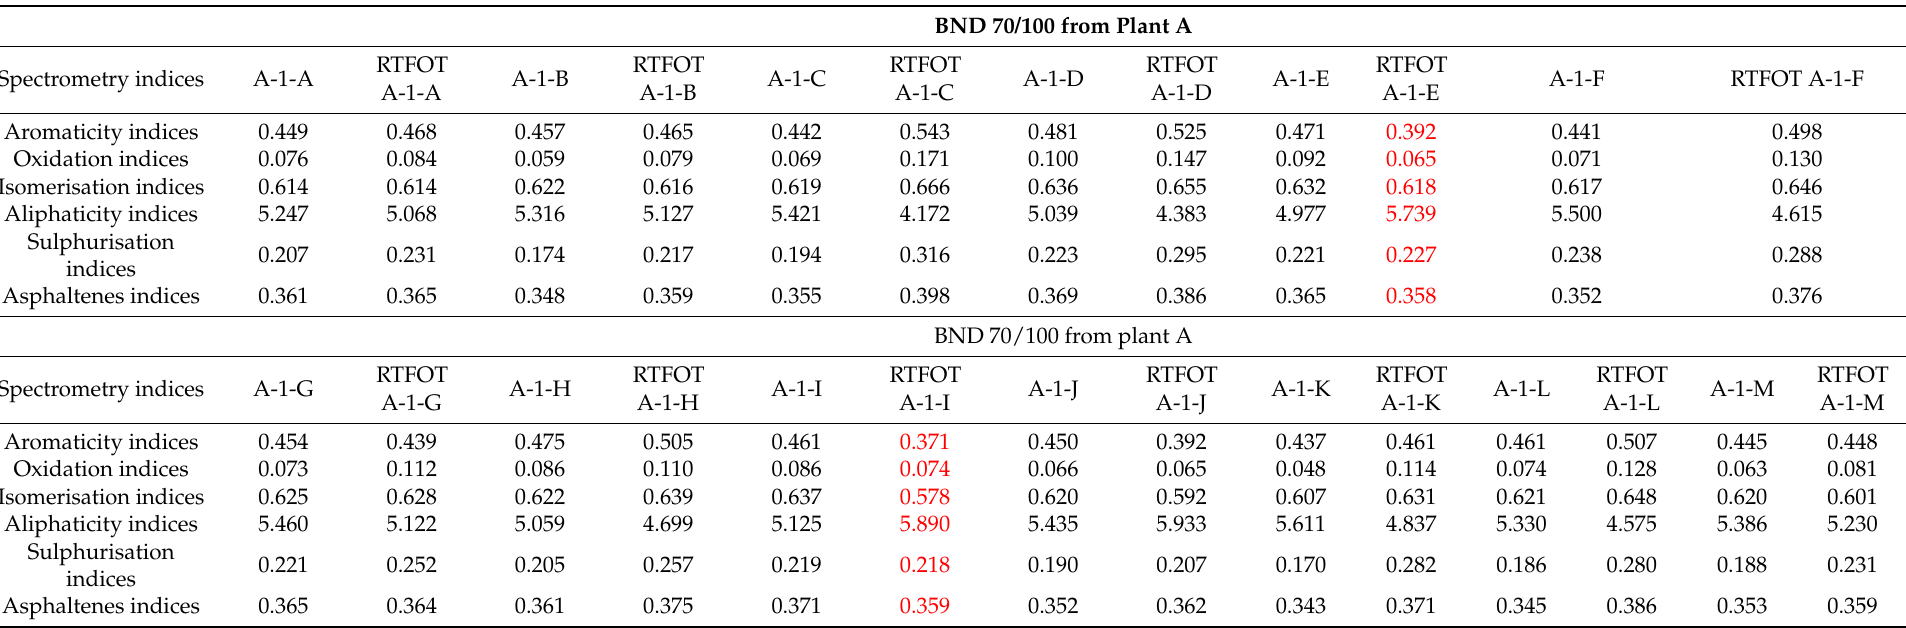
Table 8. Calculation of spectrometry indices of BND 70/100 from plant A before and after